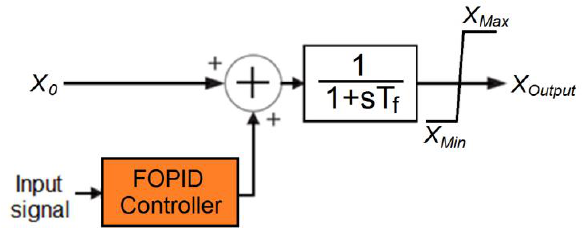
Figure 7. Dynamic model of a TCSC with the FOPID controller.